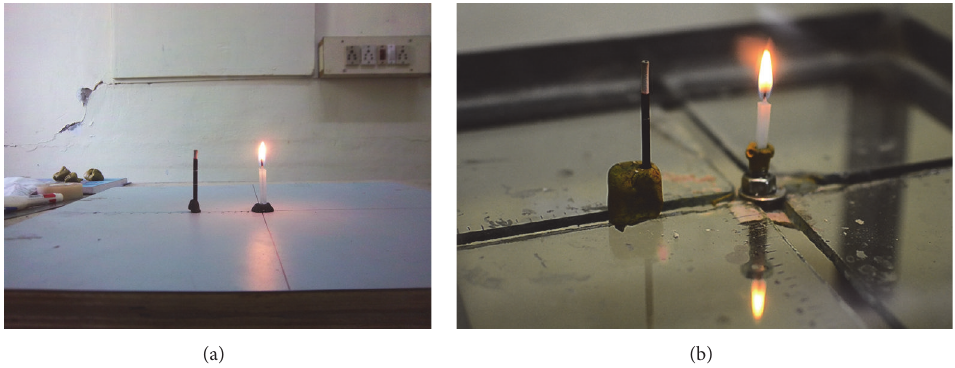
Figure 14: Pictorial view of the enclosure effect on smoldering combustion for single-fuel configuration at 5cm: (a) without enclosure; (b) with